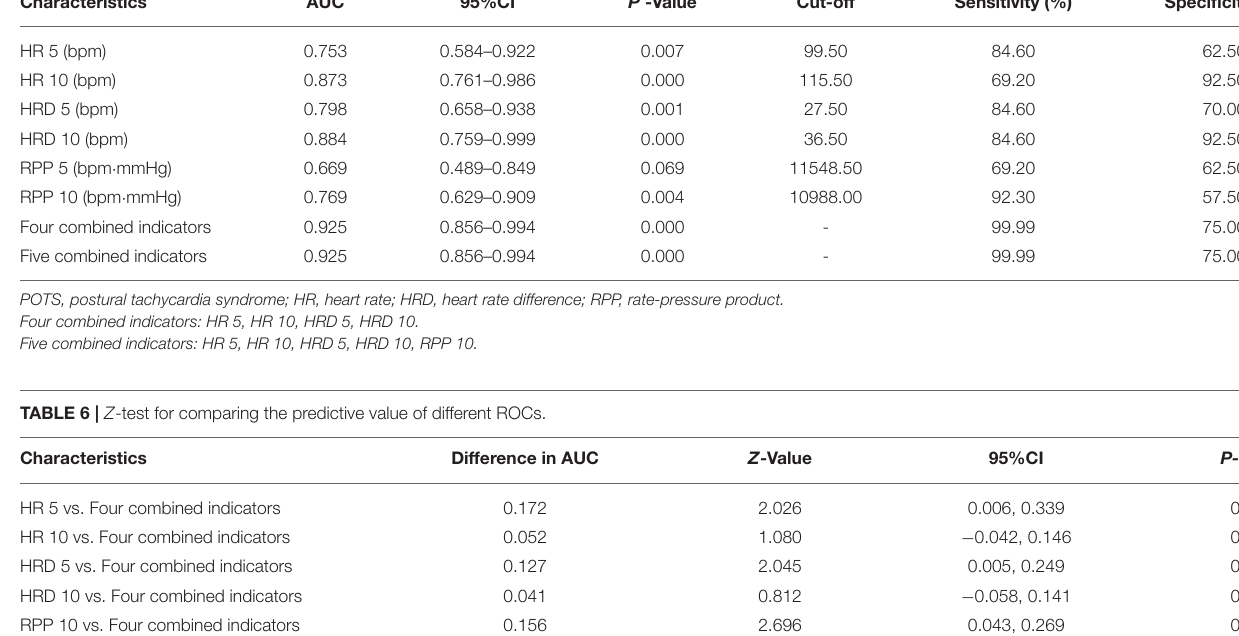
TABLE 5 | Comparison of ROC results for the predictive value of different indicators on the POTS’ prognosis. Characteristics